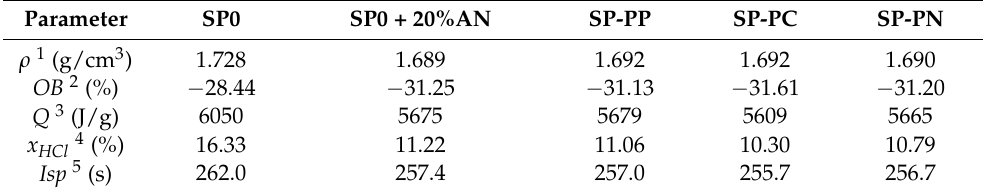
Table 3. Calculated parameters of SHRP with AP, AN and PSAN by ICT-code. Parameter SP0